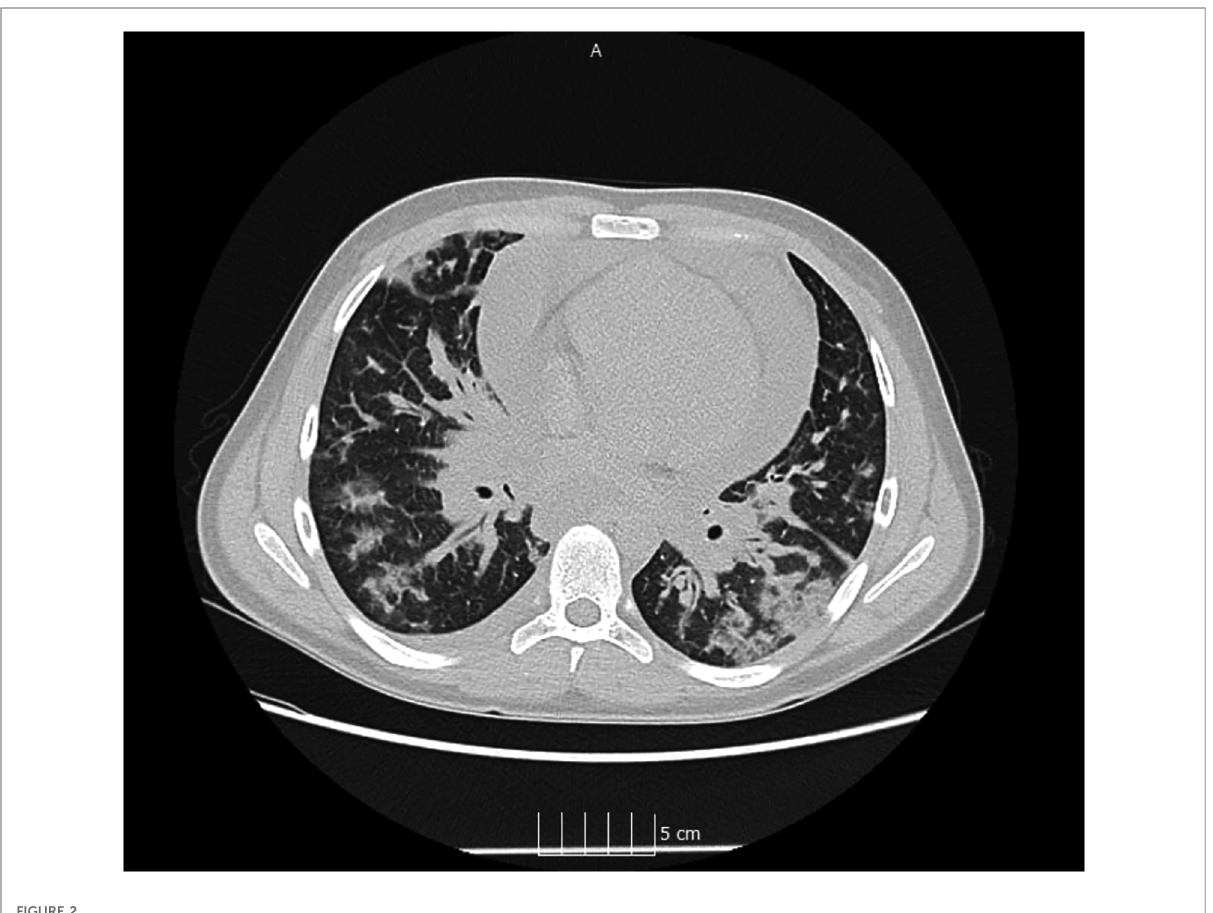
FIGURE 2 Ct image of COVID-19 pneumonia.